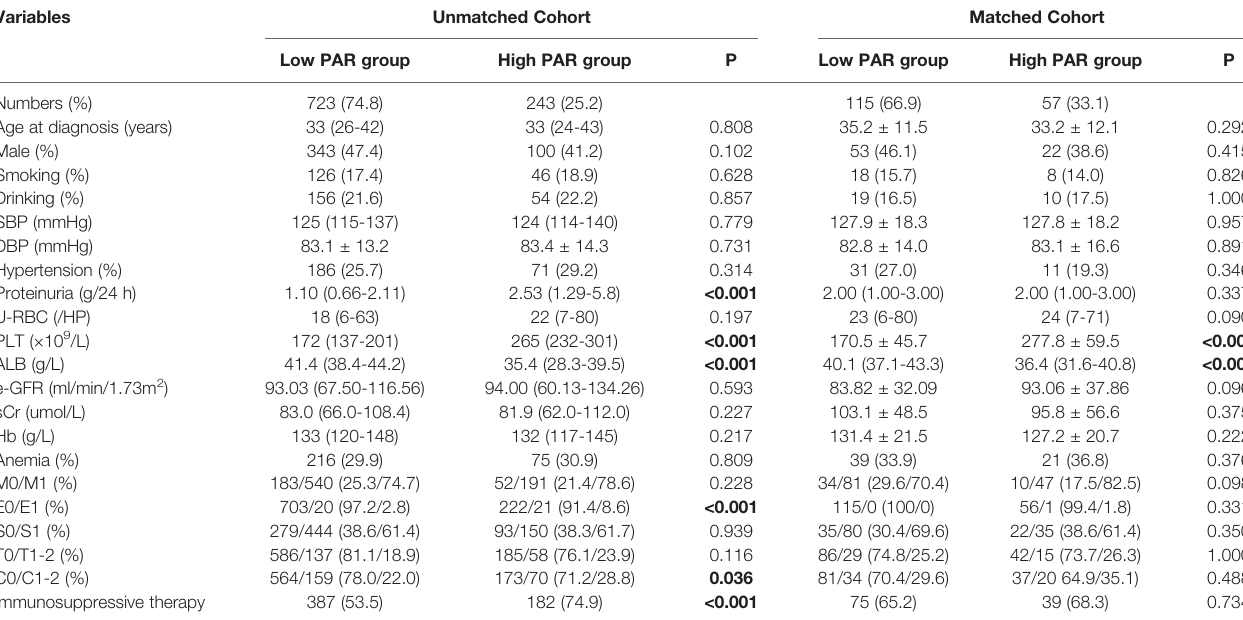
TABLE 3 | Clinicopathological manifestations of the IgAN patients at baseline, grouped by the platelet to albumin ratio.